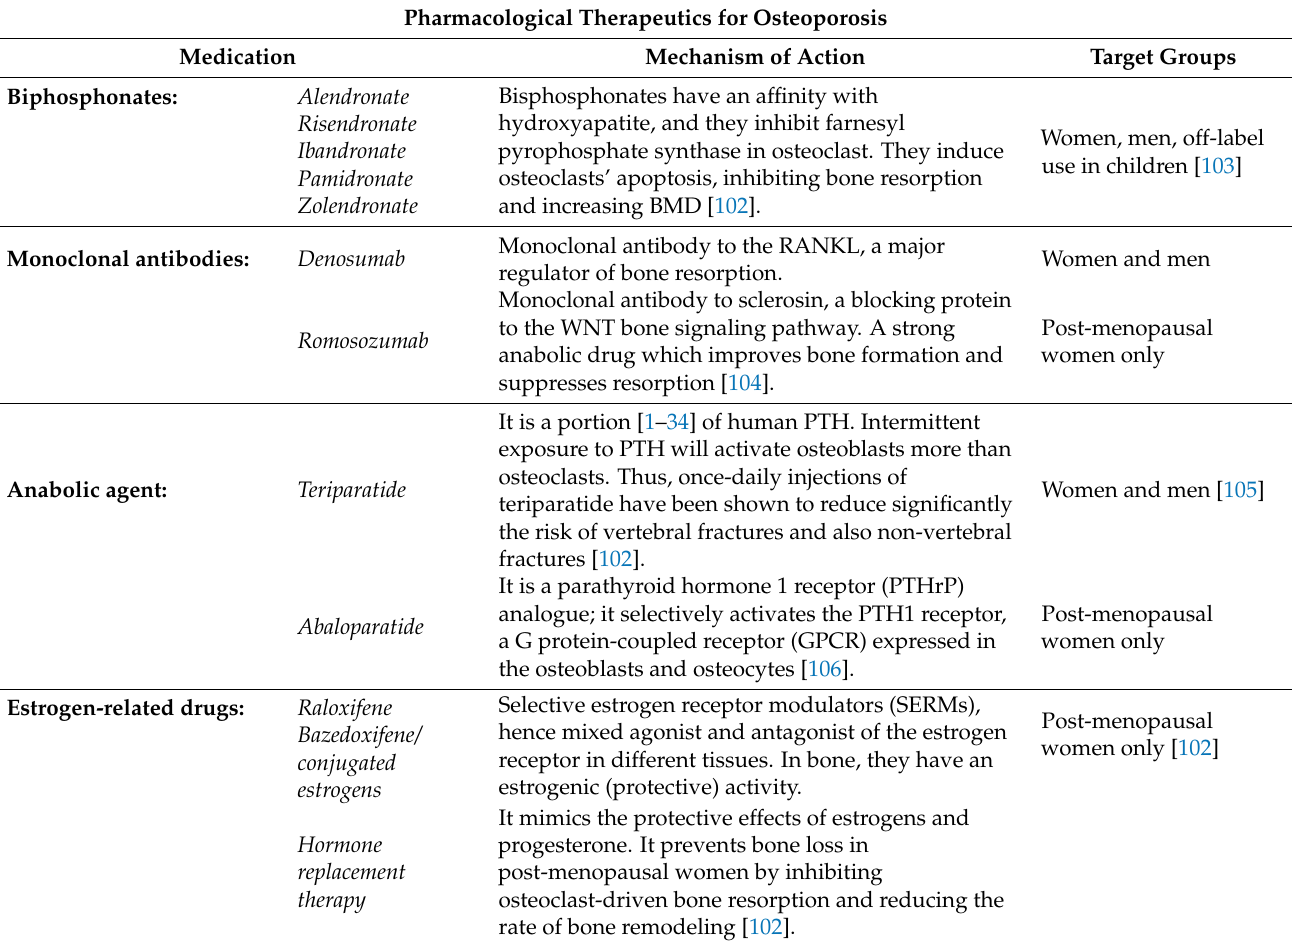
Table 1. Currently approved pharmacological agents used for adult and pediatric